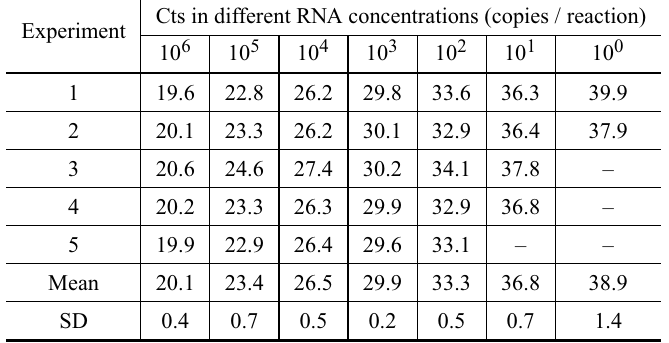
Correlation of Ct (threshold cycle) value and RNA concentration.